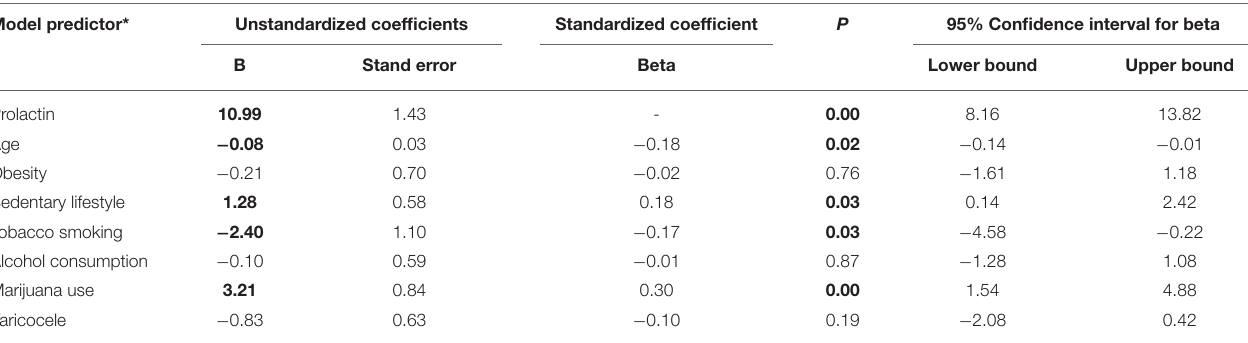
TABLE 5 | Coefficients of the multiple linear regression analysis model for dependent variable Prolactin. Model predictor* Unstandardized coefficients Standardized coefficient P 95% Confidence interval for beta Stand error Beta Lower bound